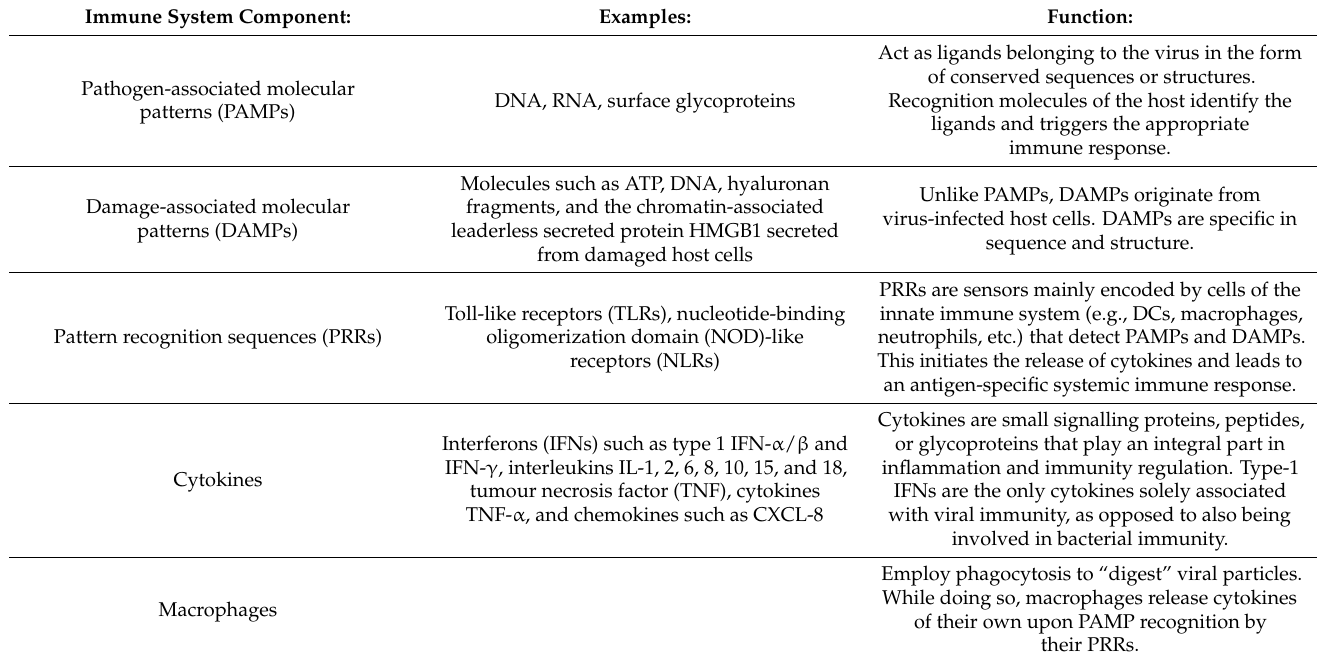
Table 1. Viral- and host-produced compounds modulated by immunobiotic LAB. Information obtained from references [42–46]. Immune System